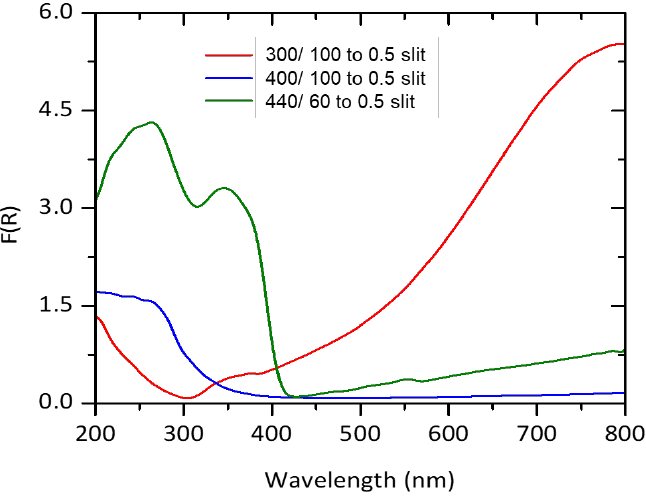
Figure 7. Kubelka – Munk absorbance function F(R) vs. wavelength of the TiO x arc-PVD coatings. Figure 7. Kubelka–Munk absorbance function F(R) vs. wavelength of the TiO